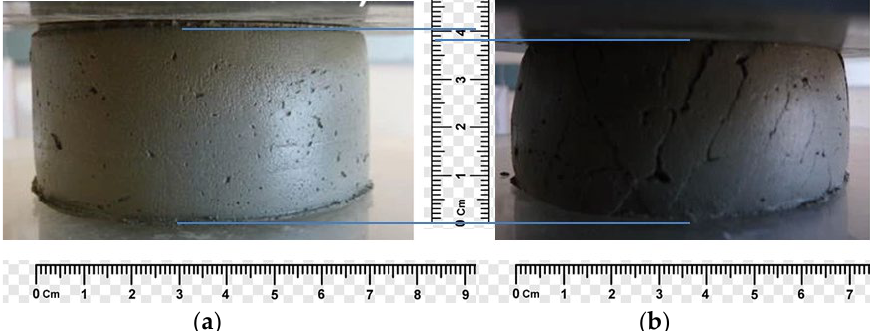
Figure 3. An example of determining the structural strength of extruded concrete: ( a ) the sample withstands the load (structural strength is provided); and ( b ) the sample is destroyed.